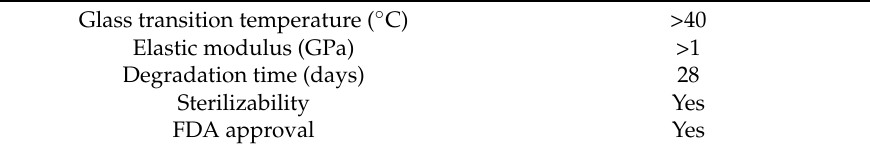
Table 1. Requirements for the biodegradable polymer [31].